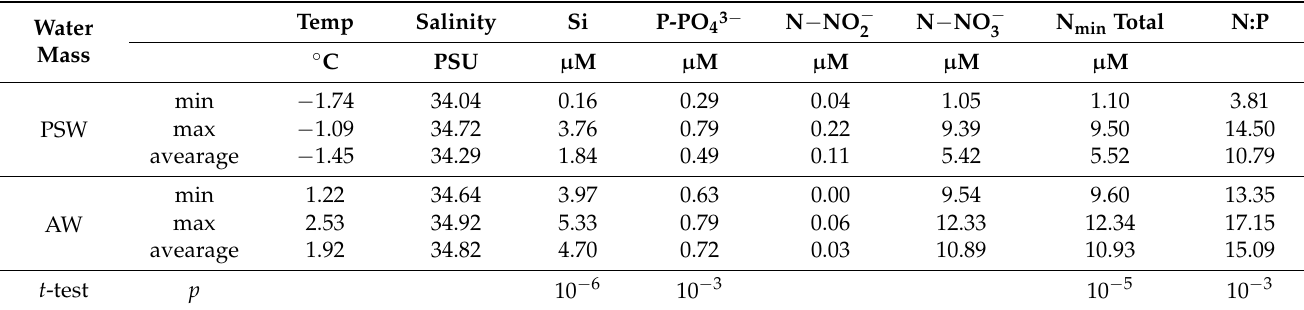
Table 2. Minimum, maximum, and average concentrations of dissolved silicon, phosphorus phos- phates, nitrogen nitrites, and nitrates, as well as the ratio of nitrogen and phosphorus in AW and PSW at all studied